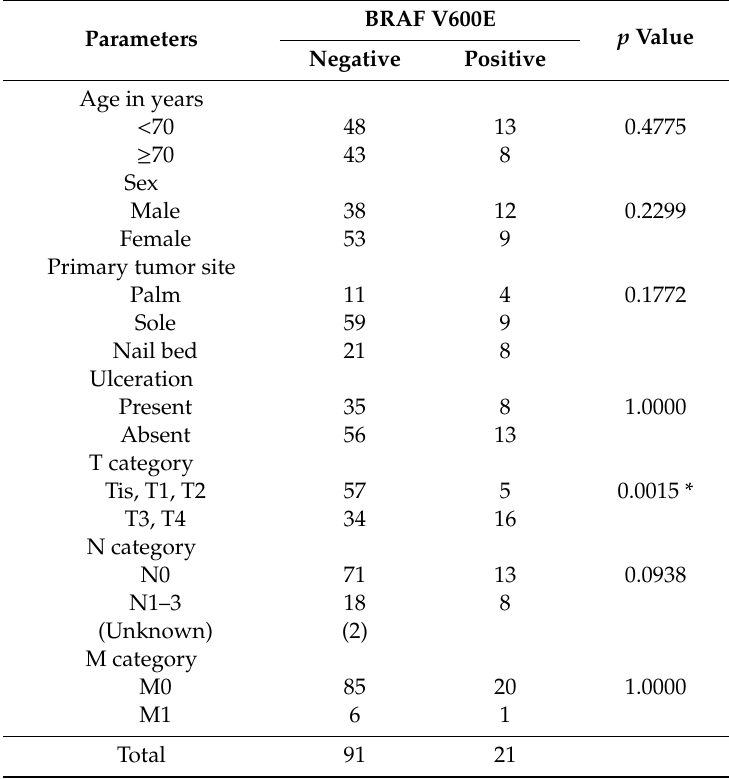
Table 2. Factors associated with BRAF V600E